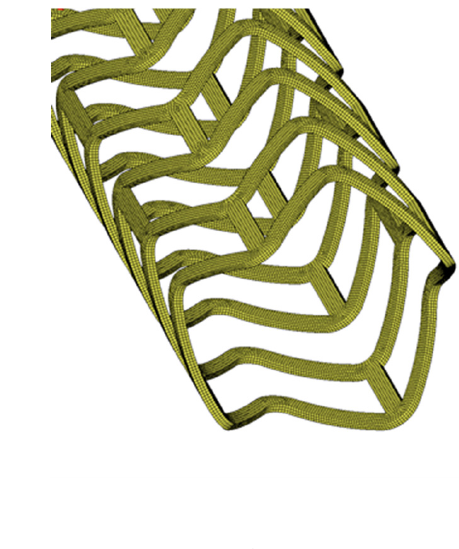
Figure 9. The modified stent model after deployment simulation selected for the crimping process: ( a ) geometry, ( b ) discretized using finite elements .